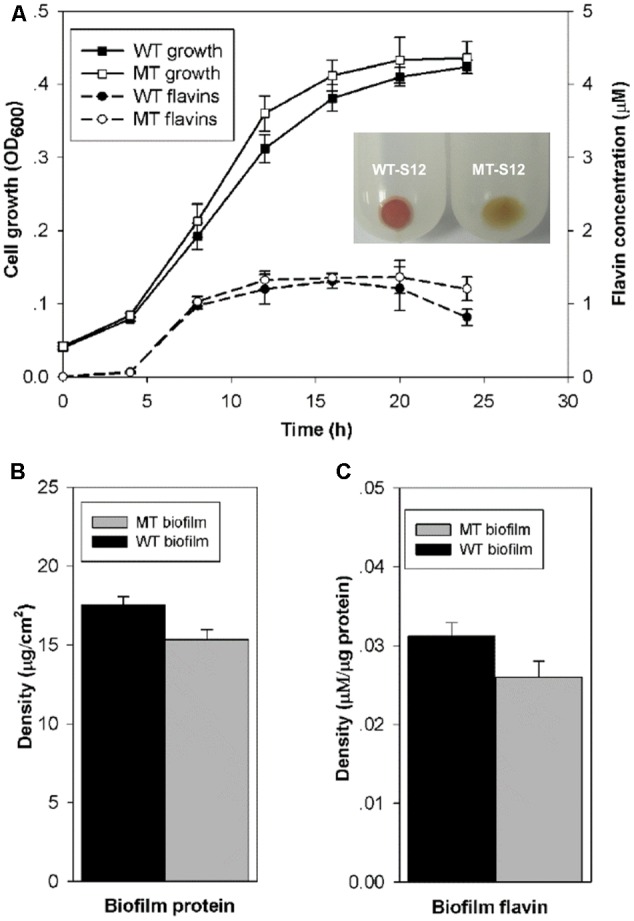
(A) Planktonic cell growth and flavin generation of WT- and MT-S12. Insert indicates the cell precipitate of WT- and MT-S12, wherein red color of the WT-S12 indicates cytochrome c on cell surface; (B) Biofilm biomass and (C) Biofilm flavins (p < 0.05). (n = 3, error bars indicate standard deviation)